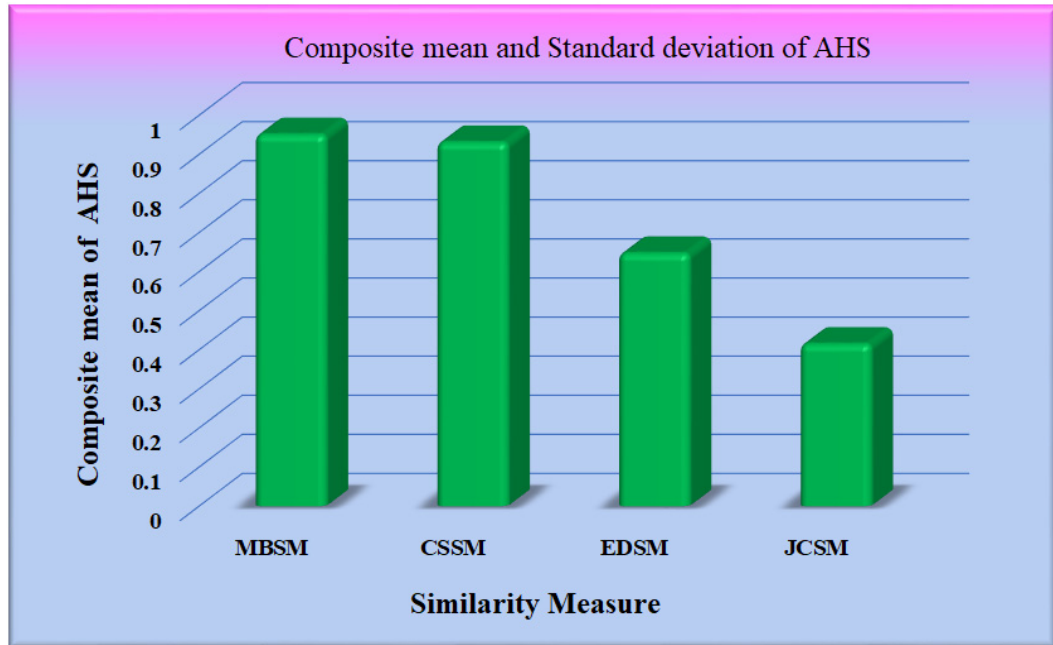
Figure 13. Graph for a mean of AHS.